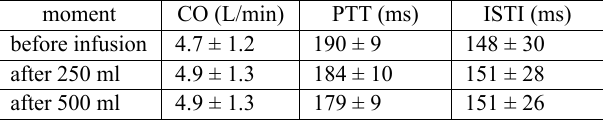
Table 1. Mean values (± S.D.) of the Cardiac Output (CO), Pulse Transit Time (PTT) and Initial Systolic Time Interval (ISTI) at three moments, before and after intravenous administration of a Gelofusine® solution in two steps of 250 ml each.